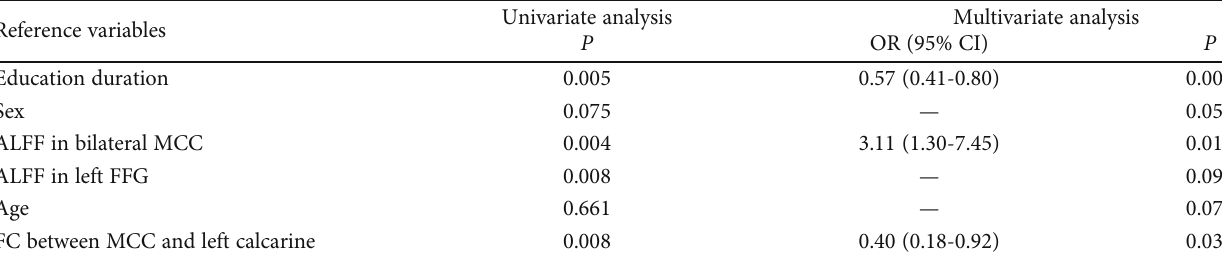
Figure 3: Brain regions exhibiting lower preoperative FC to bilateral MCC in the DNR patients compared to those in the non-DNR patients, after adjusting for age, sex, education duration, and preoperative cognitive function. The statistical threshold was set at an uncorrected voxel P < 0 : 001 and a corrected cluster P < 0 : 05 (cluster-based FDR corrected). DNR: delayed neurocognitive recovery; FC: functional connectivity; FDR: false discovery rate; MCC: middle cingulate cortex. Table 3: Risk factors for